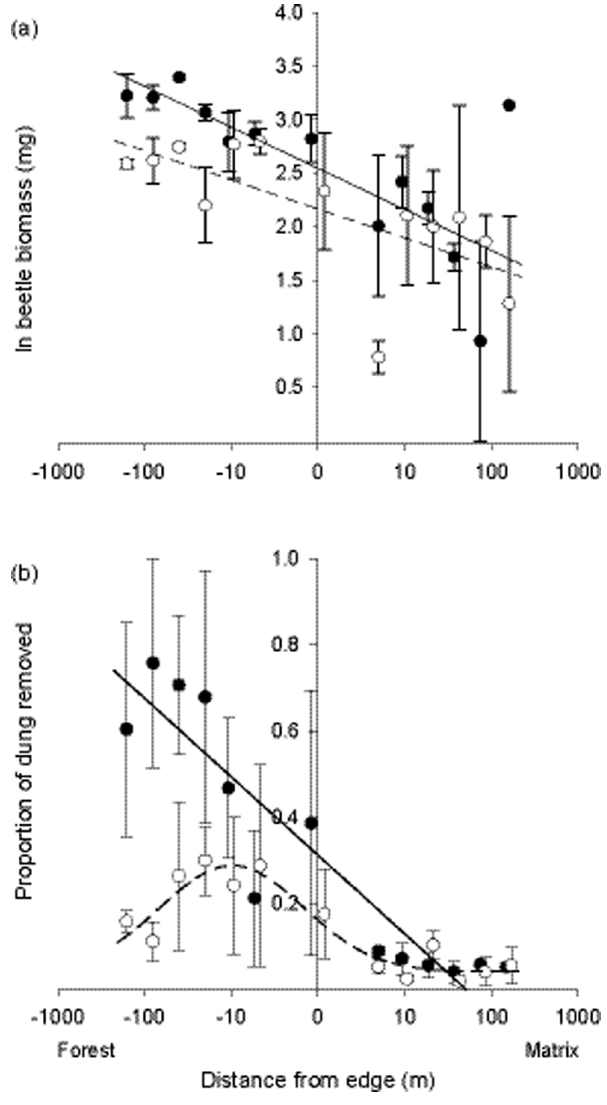
Fig. 2. Variation in total beetle biomass and proportion of dung removed across degraded and regenerating edges. Points and error bars are mean ¡ 1 SE. Open symbols and dashed fitted lines denote degraded edges, whereas closed symbols and solid fitted lines denote regenerating edge gradients. Negative values on the x-axis indicate forest sites. Lines are the best-fit continuous edge response functions of five fitted models of increasing complexity. Both model fits in (a) are linear, while the model fit for regenerating edges in (b) is linear and for degraded edges in (b) is unimodal (see Appendix S3). Overlapping points are offset for